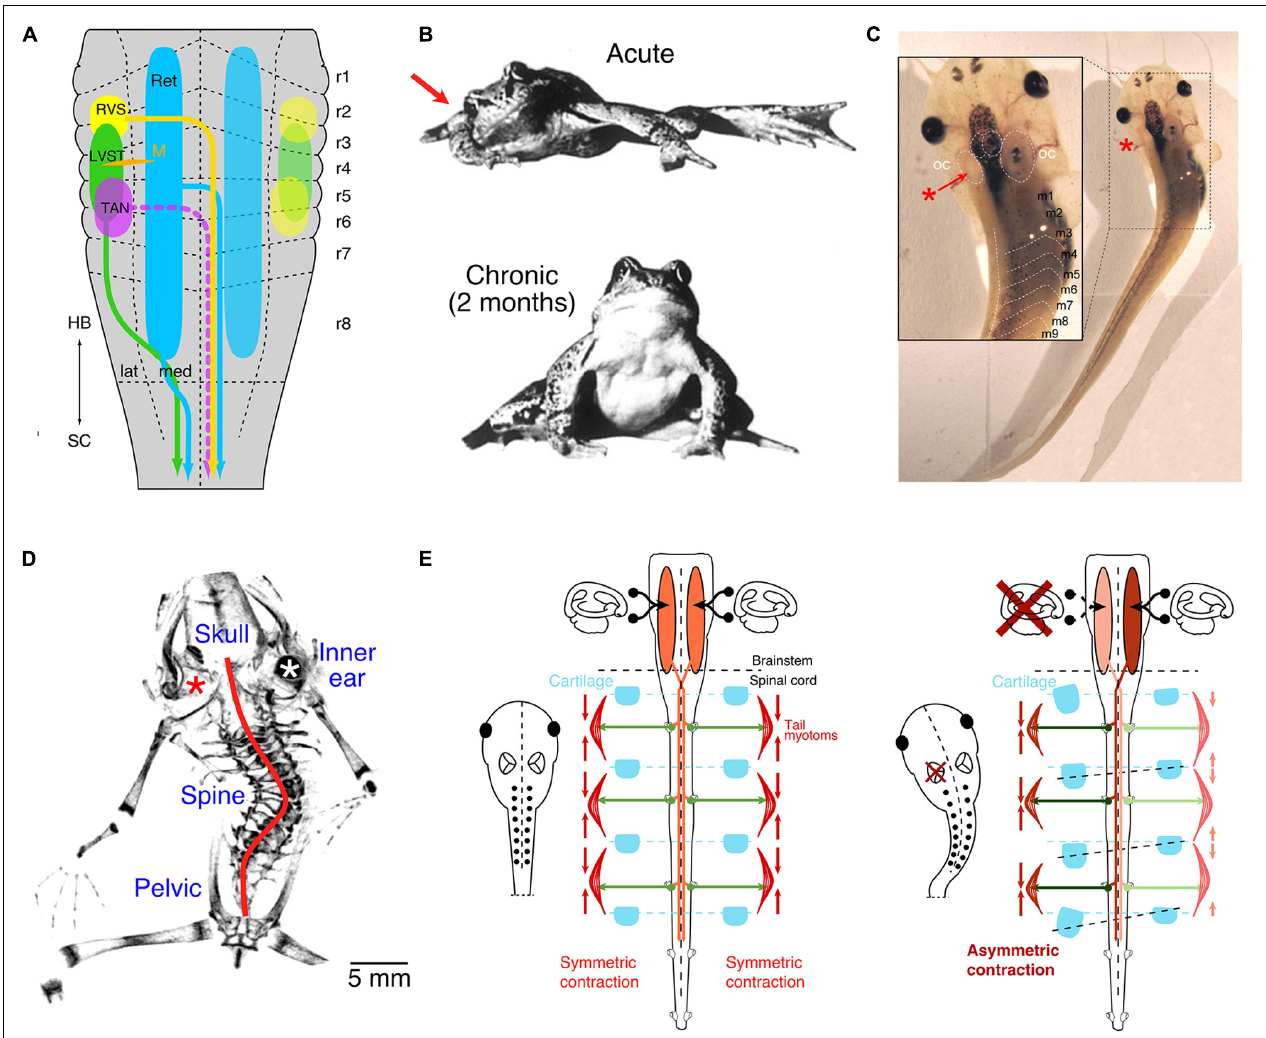
FIGURE 1 | Vestibulo-spinal projections and impact of unilateral vestibular impairments. (A) Schematic depicting the segmental origins (color-coded) of vestibulo-spinal and vestibulo-reticulo-spinal pathways. (B) Photographs of a ranid frog immediately (upper) and 2 months (lower) after a unilateral vestibular lesion on the right side (red arrow). (C) Photograph of a Xenopus laevis tadpole immediately after unilateral removal of the vestibular endorgans in the left inner ear (red *, see inset). (D) Micro-CT scan of the skeleton of a post-metamorphic frog after removal of the left inner ear endorgans (red *) at mid-larval stage; the red line indicates the scoliotic deformation. (E) Schematic depicting descending vestibular pathways, spinal motor activity, contraction of axial muscles and relative arrangement of skeletal elements in controls (left panel) and after unilateral labyrinthectomy on the left side (right panel). LVST, lateral vestibulo-spinal tract; m1–9, myotome 1–9; M, Mauthner cell; RVS, rostral vestibulo-spinal tract; OC, otic capsule; r1–8, rhombomere 1–8; TAN, tangential vestibular nucleus; lat, lateral; med, medial; HB, hindbrain; SC, spinal cord; Ret, reticular formation. (A,C,D) From Lambert et al. (2013); (B) , from Dieringer (1995) with permission from Elsevier (E) , from Lambert et al.